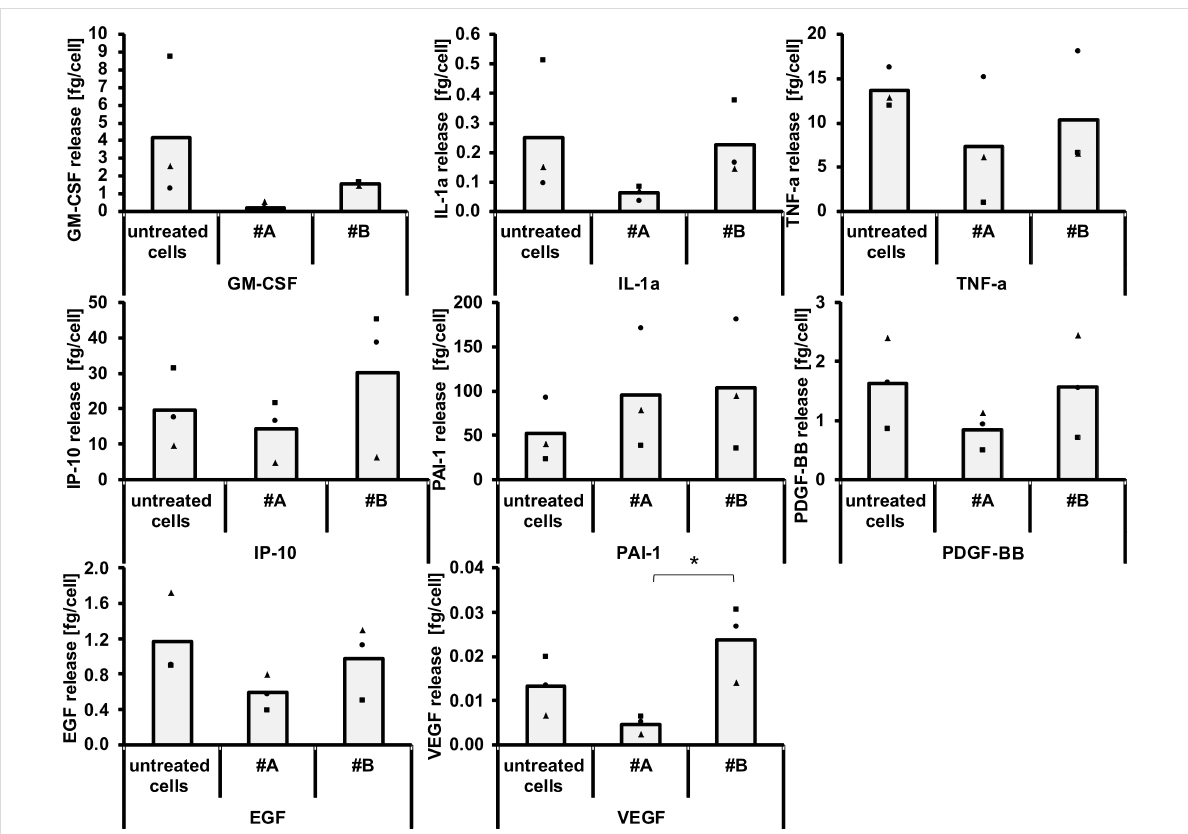
Figure 5: The impact of CeO 2 nanoparticles on the release of GM-CSF, IL-1 α , TNF- α , IP-10, PAI-1, PDGF-BB, EGF and VEGF. HUVEC were treated with CeO 2 nanoparticles (sample #A or sample #B, see text; 100 µg/mL) for 24 h. n = 3 independent experiments; *asterisks indicate significant differ- ences (P ≤